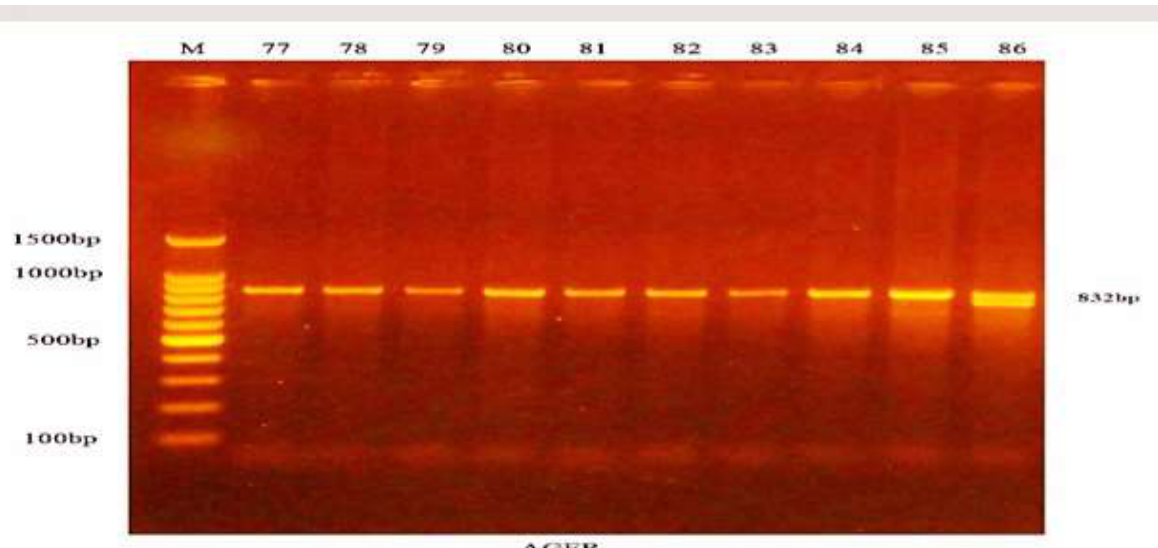
Figure 3. Gel electrophoresis for PCR product of AGER: Results of the amplification of AGER specific gene region of Human samples were fractionated on 1.5% agarose gel electrophoresis stained with Eth.Br. M: 100bp ladder marker. Lanes 77-86 resemble 832bp PCR products Table 4. Comparison between biochemical parameters of the patients group A according to AGER